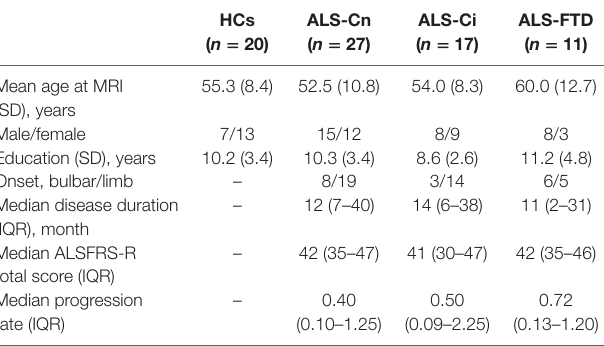
TaBle 1 | Demographic and clinical characteristics of included